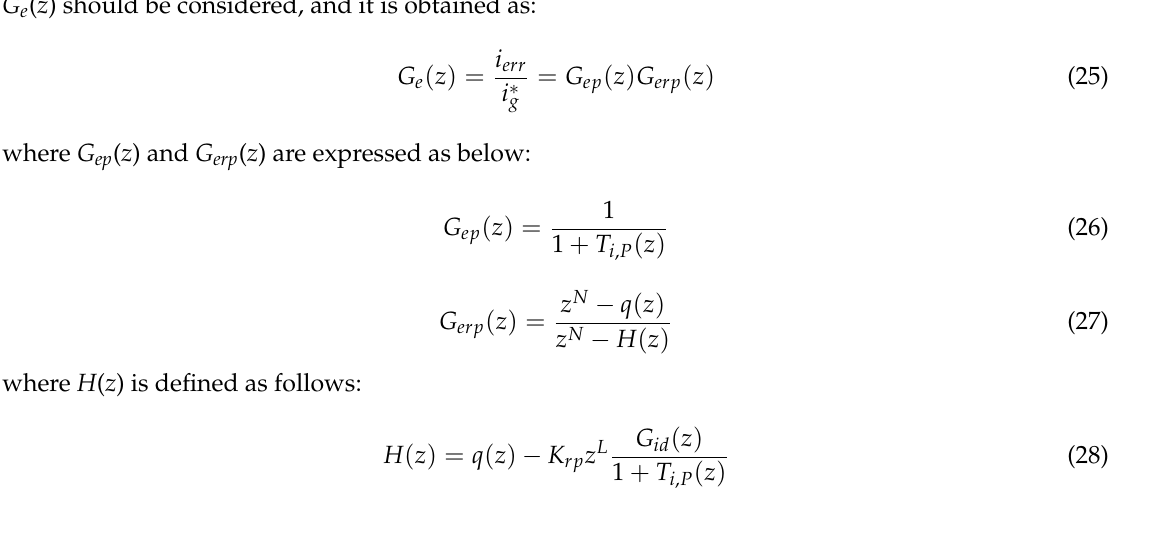
Figure 7. Frequency response of T i ( z ): ( a ) Buck mode; ( b ) Boost mode.